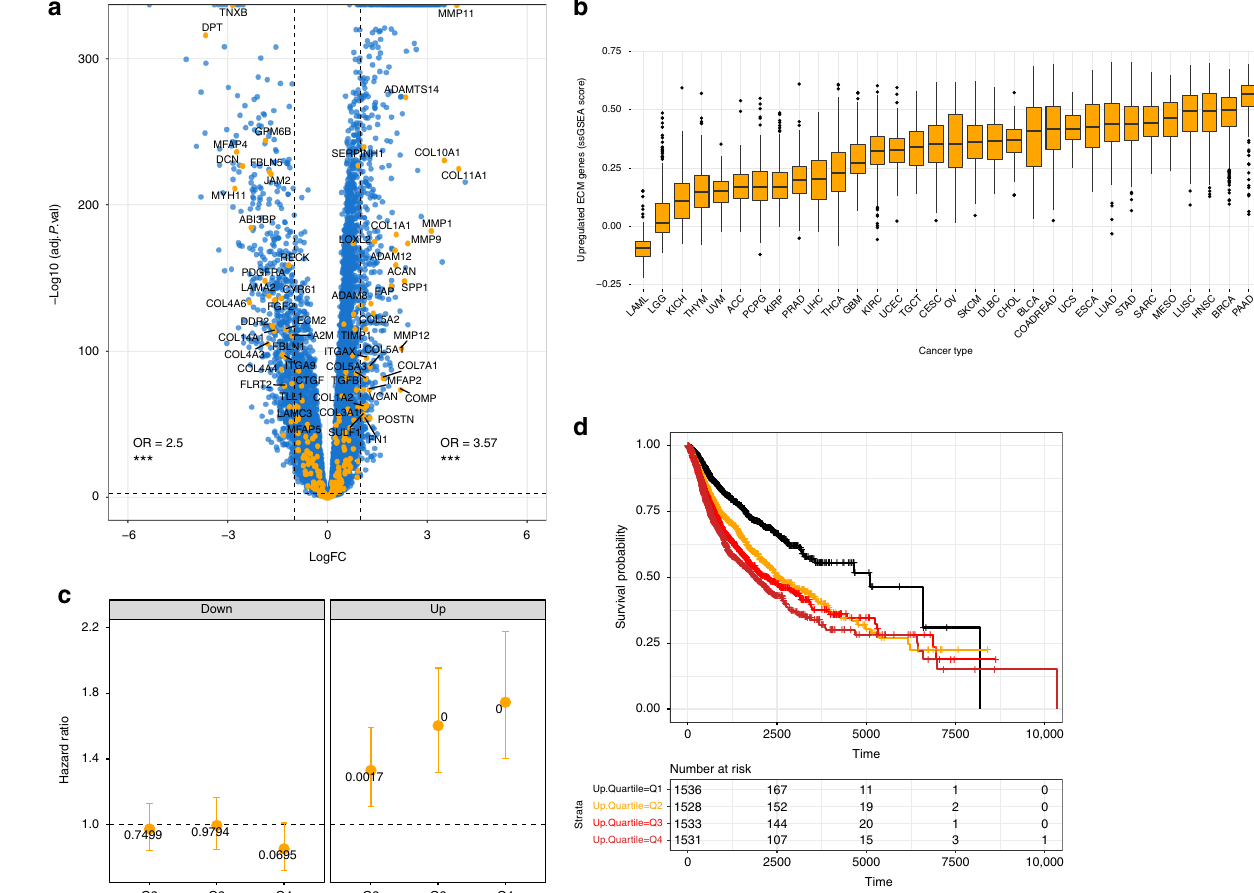
Up.Quartile=Q4Up.Quartile=Q3Up.Quartile=Q2Up.Quartile=Q1 Fig. 1 ECM genes are signi fi cantly associated with tumorigenesis and prognosis. a Volcano plot showing fold changes for genes differentially expressed between cancer and normal samples. ECM genes are enriched in upregulated and downregulated genes. b Boxplots of C-ECM-up enrichment scores show variation across tumour types ( n = 9716, see S1F for C-ECM-down genes). c Plot of Cox model coef fi cients by quartile for C-ECM-up and -down scores pan-cancer, error bars indicate 95% con fi dence intervals ( n = 6128). d Unadjusted Kaplan – Meier curves showing survival by C-ECM-up-quartile., asterisks indicate statistical signi fi cance. *** p < 0.001. On the volcano plot, y axis = − log 10 fold change, x axis = test statistic/fold change/Spearman ’ s Rho. On volcano plots, all enrichment statistics are from Fisher ’ s Exact